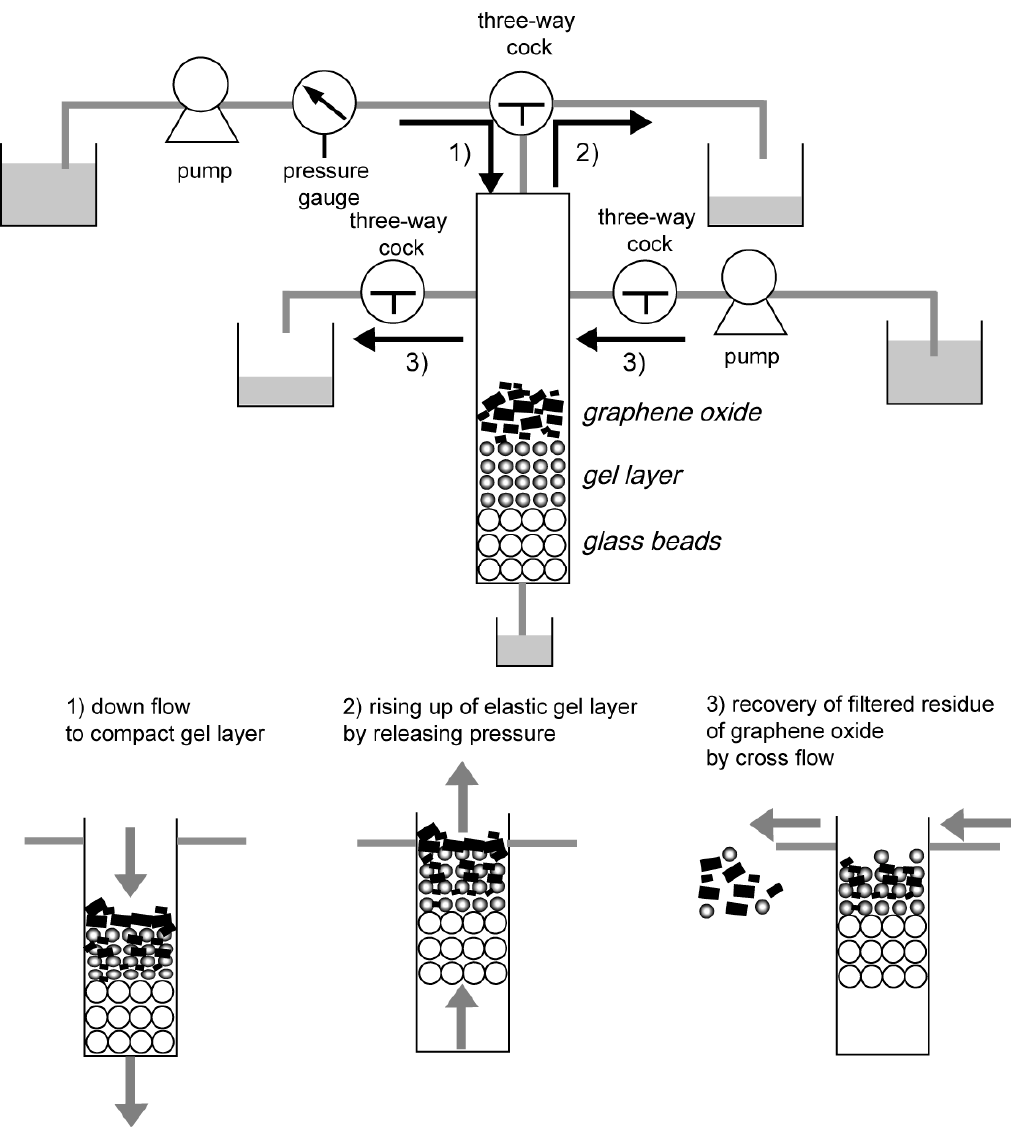
Figure 1. Illustrated scheme of the recovery of filtered residues by using the elasticity of gels and cross flow.